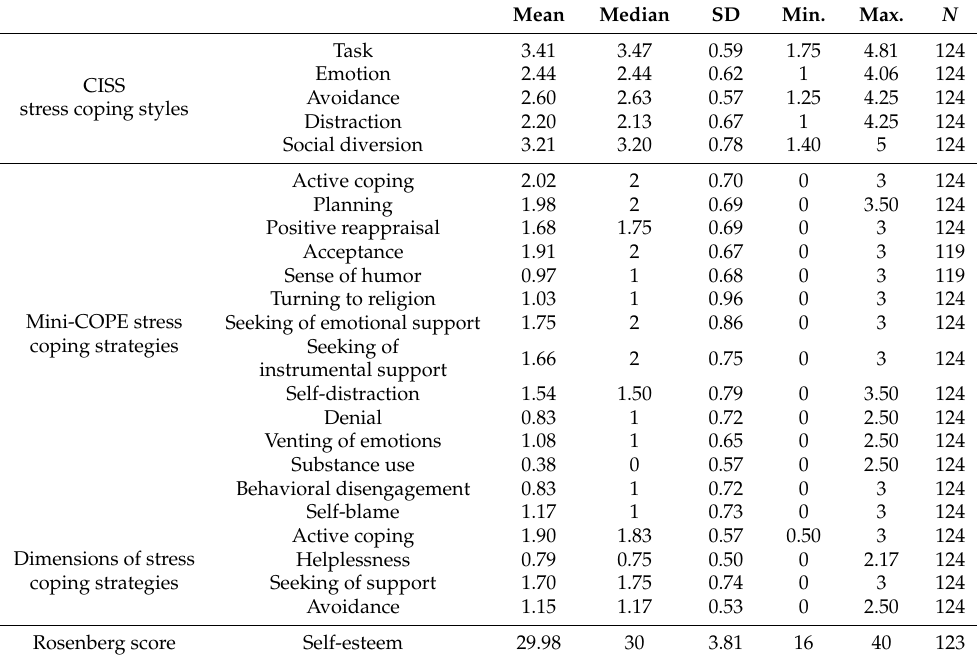
Table 2. Results of the CISS, Mini-COPE and Self-Esteem-Scale questionnaires.